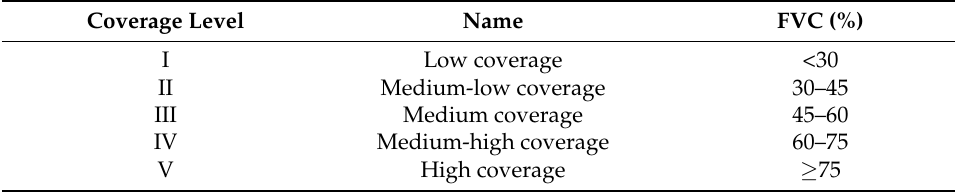
Table 2. Classification of fractional vegetation cover (FVC) level in the study